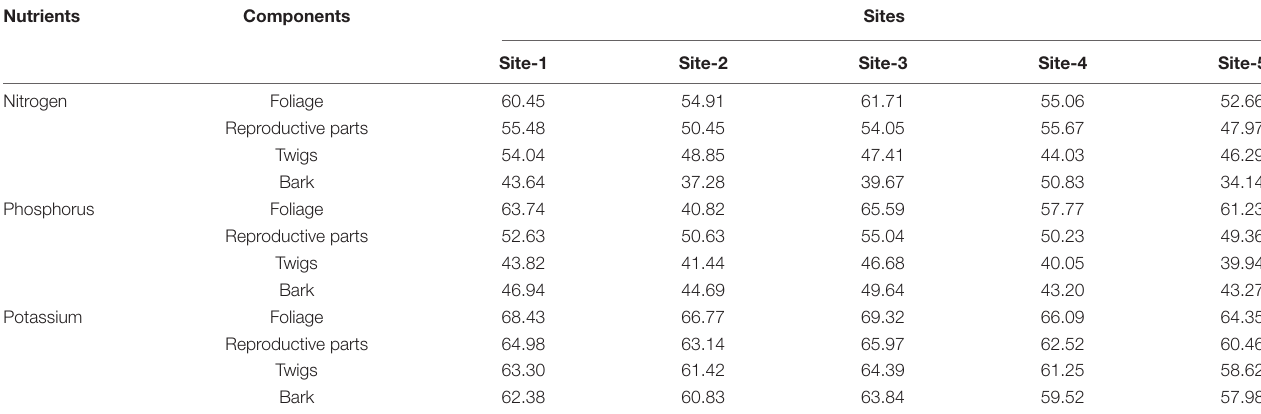
TABLE 9 | Percent nutrient retranslocation efficiency (%) at different selected sites for different litter components. Nutrients